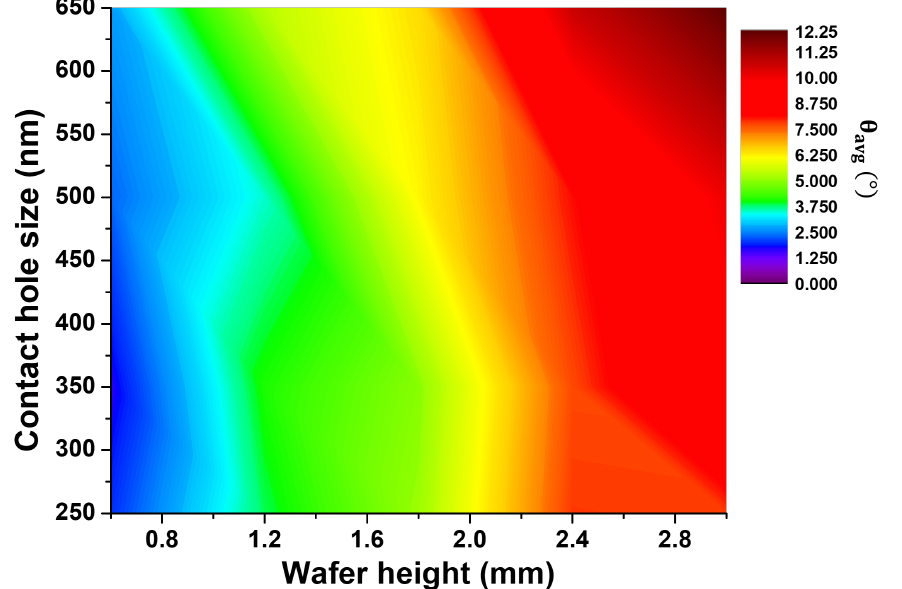
Figure 8. Contour map of the angle difference of the etched sidewall as functions of wafer height and contact hole size at the wafer